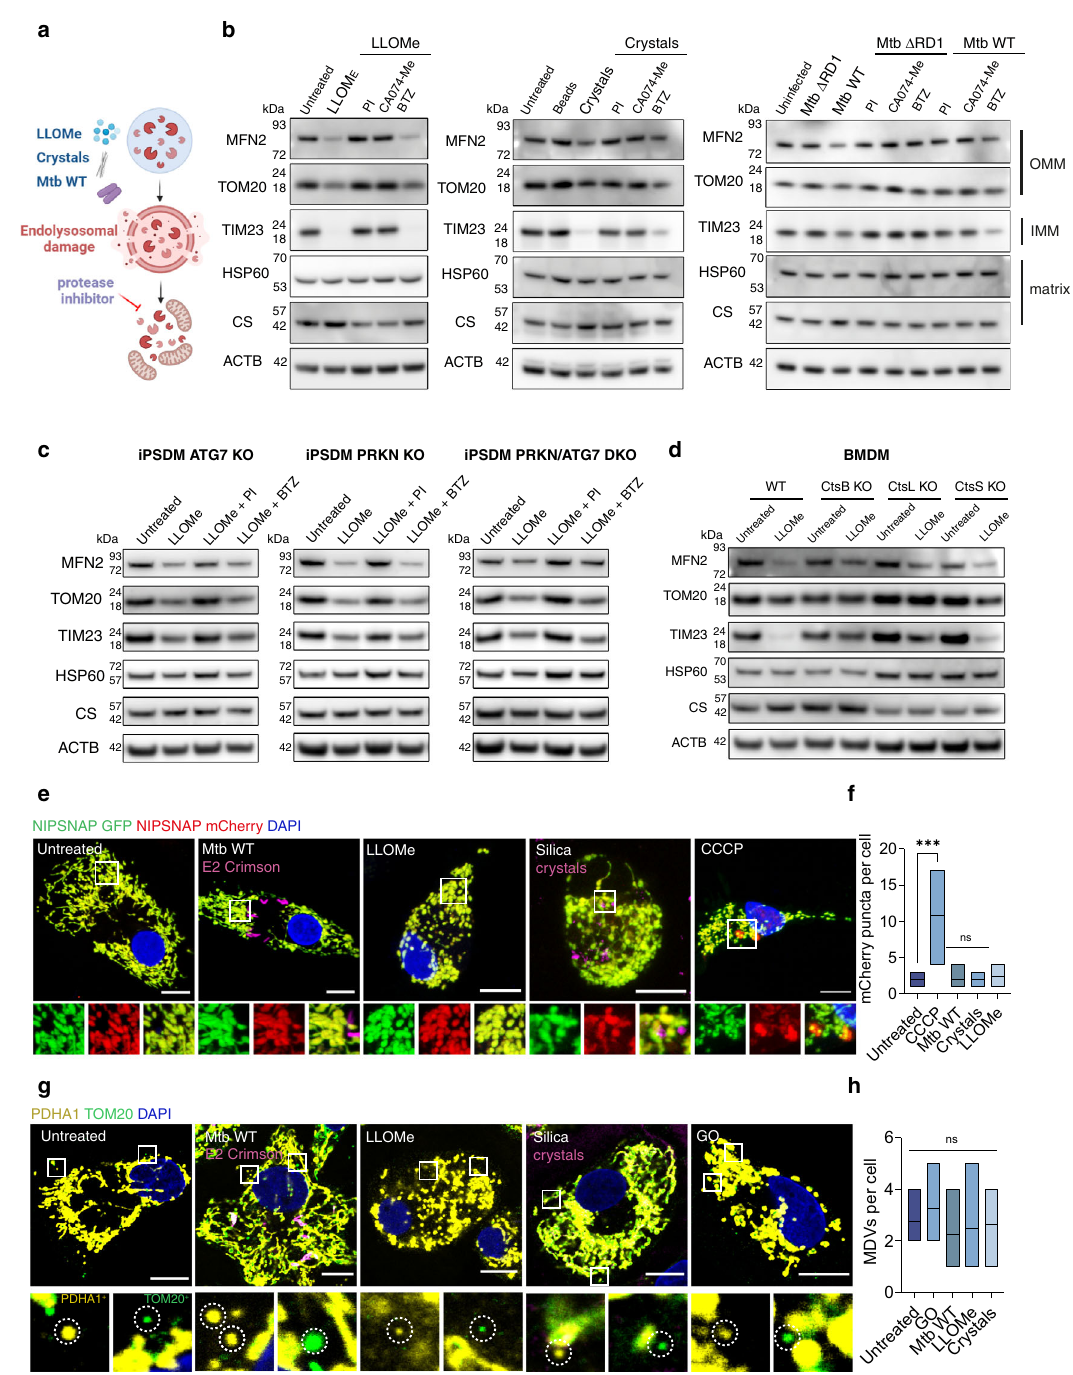
Fig. 1 | Lysosomal protease leakage triggers mitochondrial protein degrada- tion in macrophages. a Schematic showing the conditions tested in this study. b Immunoblots for MFN2, TOM20, TIM23, HSP60 and Citrate synthase (CS) in iPSDMstimulatedwith0.5mMLLOMefor1h,100 μ g/mLsilicacrystalsorbeadsfor 3horinfectedwithMtbWTorMtb Δ RD1for48handincubatedwiththeindicated protease or proteasome inhibitors. Beta-actin (ACTB) levels were used as loading controls (repeated three times with similar results). c Immunoblots for mitochon- drial proteins in iPSDM WT, ATG7 KO, PRKN KO and PRKN/ATG7 DKO stimulated with 0.5mM LLOMe for 1h and incubated in the presence or absence of the indi- cated inhibitors (repeated three times with similar results). d Immunoblots for mitochondrialproteinsinBMMWT,CtsBKO,CtsLKOandCtsSKOstimulatedwith 0.5mMLLOMefor1h.(repeatedthreetimeswithsimilarresults). e Representative